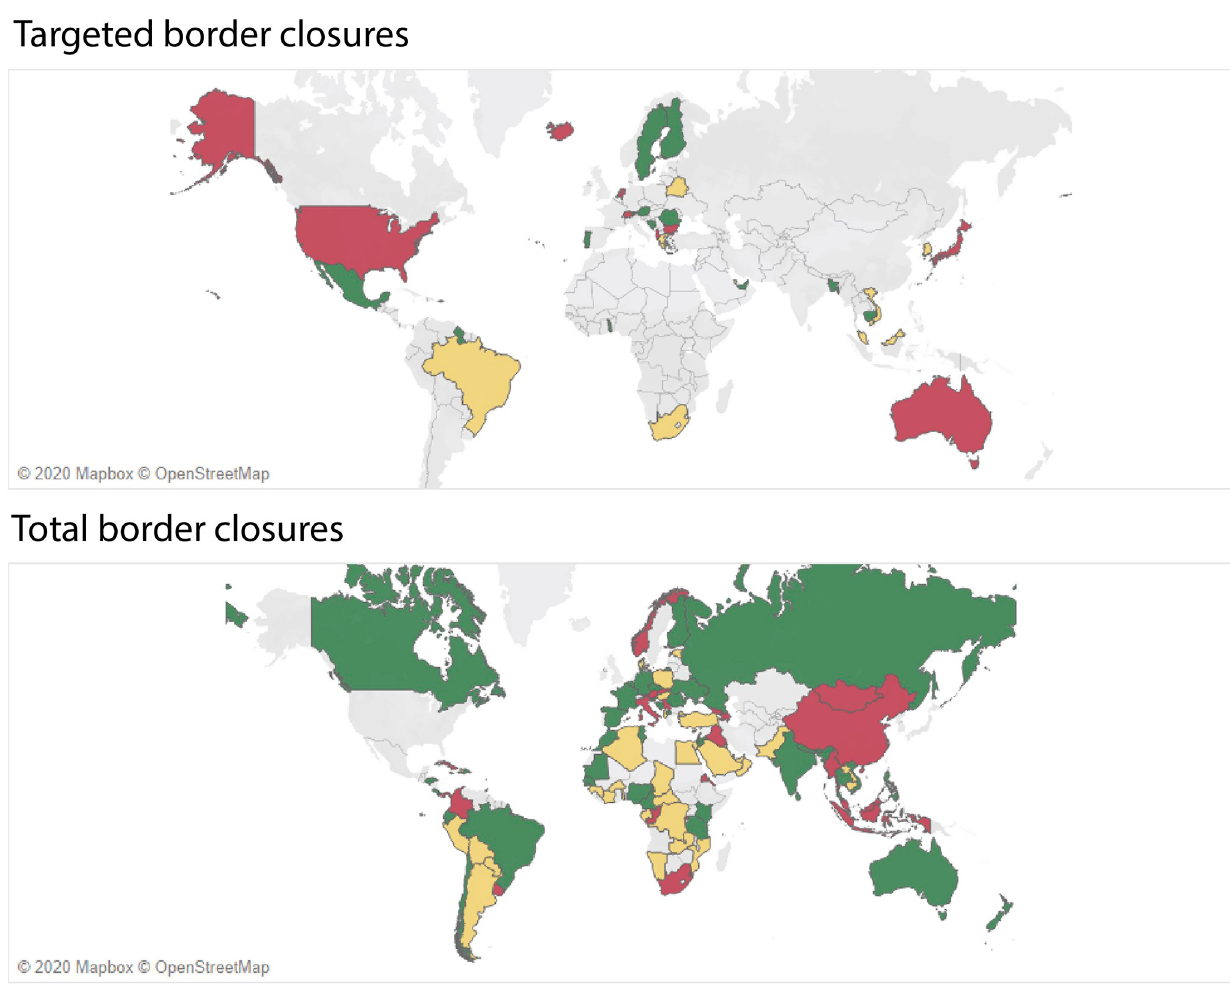
Fig 3. Country-specific ITS results for targeted and total border closures. Map of targeted (top) and total (bottom) border closures that produced positive effects (i.e., decreased Rt) (green), negative effects (i.e., increased R t ) (red), and null or mixed effects (yellow) for all five-day lagged evaluations using ITS analysis. Map base layer from © OpenStreetMap can be accessed at https://www.openstreetmap.org.